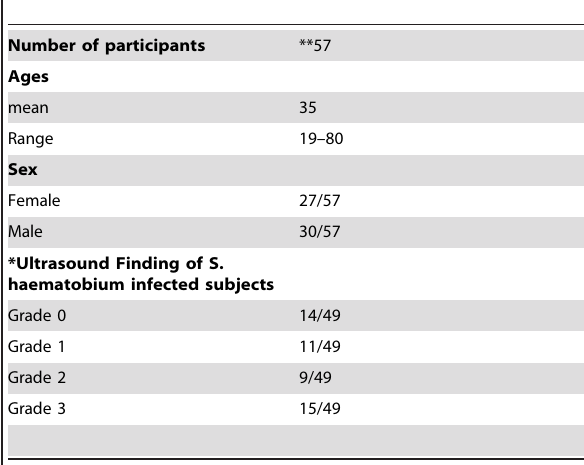
Table 1. Demographic and clinico-pathological parameters of